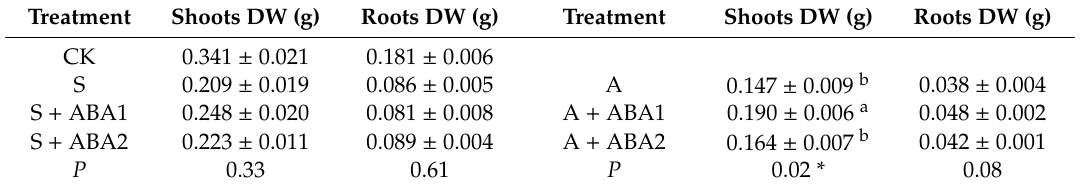
Table 1. The biomass of wheat seedlings under salt and alkali stresses and abscisic acid (ABA) treatment. Treatment Shoots DW